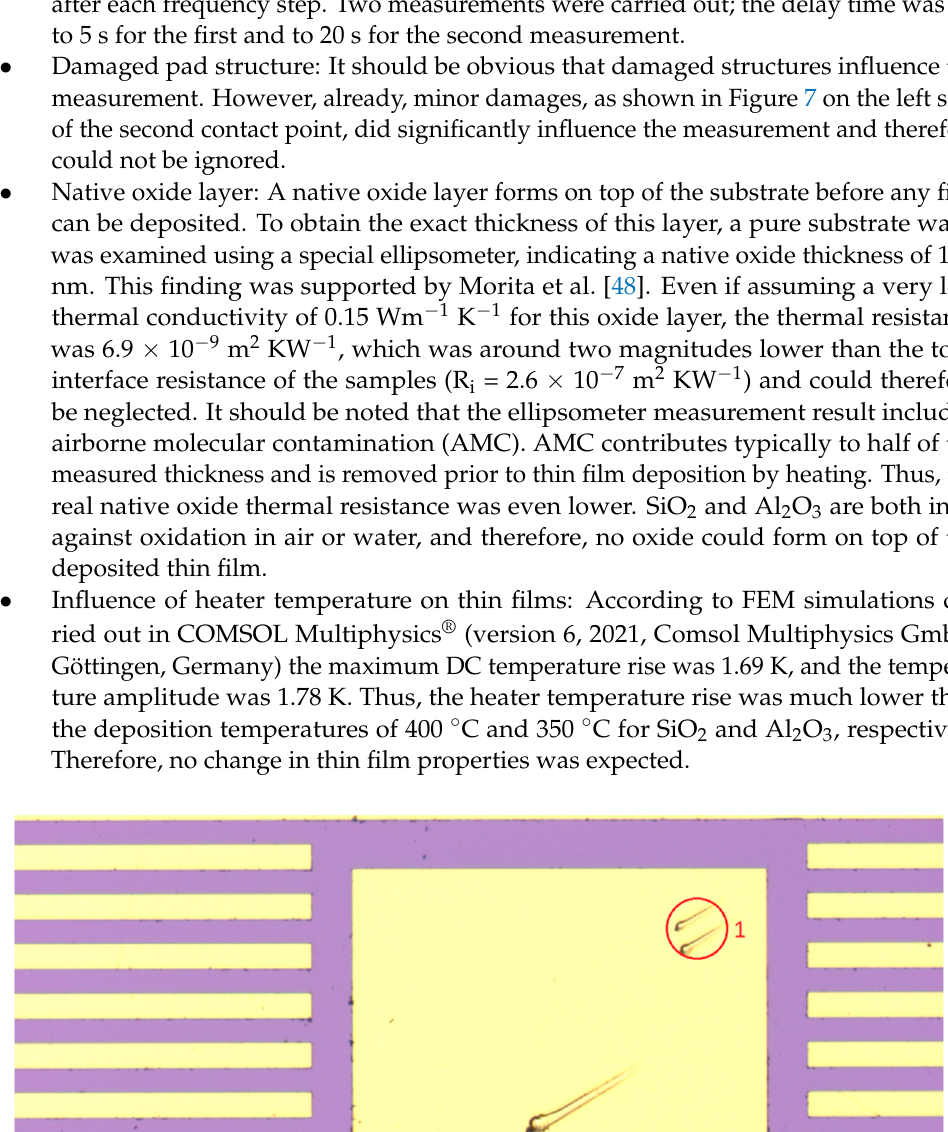
Figure 8. LSM measurements of penetration depths for ( A ) contact force 1 and ( B ) contact force 2. The left images show the complete LSM scans, while the right images show the cross-sections indi- cated in the left images. As depicted in Table 4, the results showed that the heater structure had to be in flaw- less condition for stable and precise results, while all other parameters did not influence the measurement result significantly. Table 4. Results for different potential measurement influences for a 1 µm thin SiO 2 thin film. The deployed heater geometry, investigated parameters, and measurement results are shown.